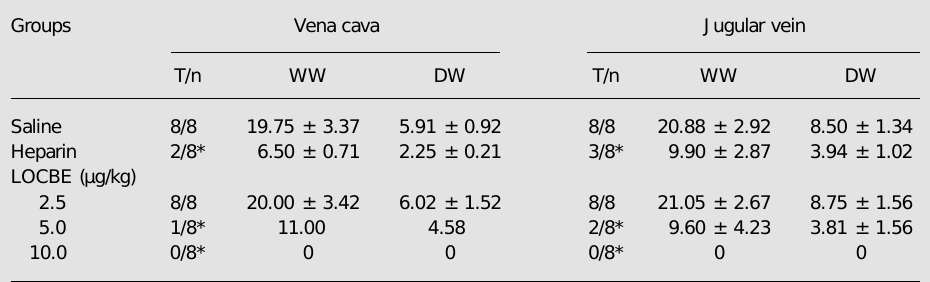
Table 1. Effect of Lonomia obliqua caterpillar bristle extract (LOCBE) and heparin (300 IU/kg) on the frequency and weight of thrombi induced in the vena cava and jugular vein of rats. Groups Vena cava Jugular